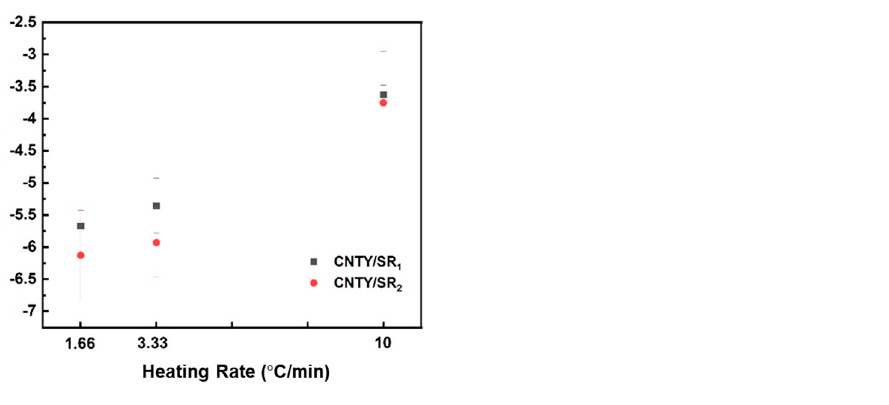
Figure 9. Temperature coefficient of resistance of CNTY/SR 1 and CNTY/SR 2 monofilament composites for various heating rates, respectively.